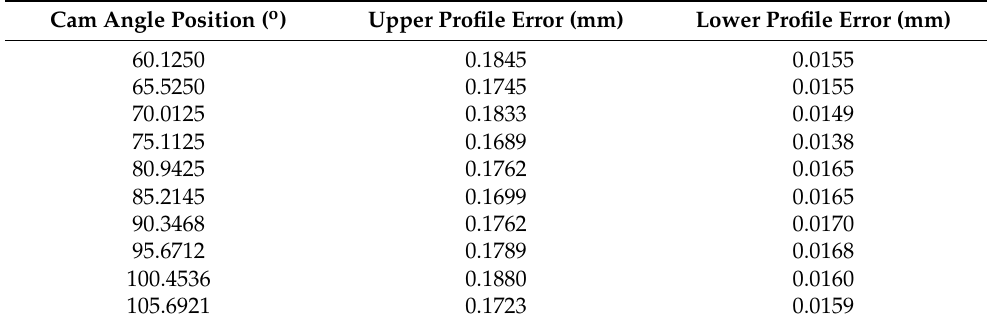
Table 5. The evaluation result of the contour error of the rest Section